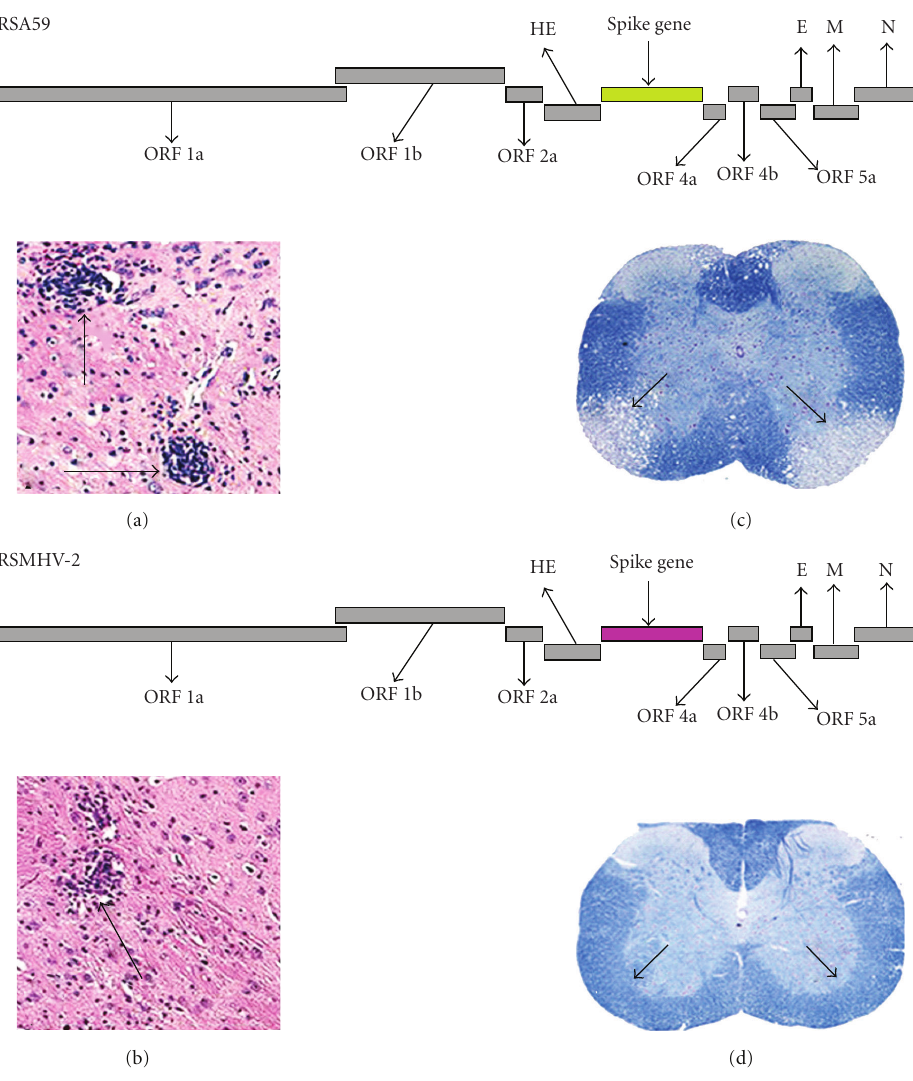
Figure 9: Comparative CNS pathology of mice infected with isogenic recombinant strains di ff ers in the S gene. Schematic diagram of isogenic recombinant strains RSA59 (S gene denoted in green color) and RSMHV2 (S gene demoted in pink color). Encephalitis (a, b). Haematoxylin- and eosin stained brain sections from the basal fore brain of mice infected with either RSA59 (a) or RSMHV2 (b) at day 5 post infection. Arrows indicate regions of inflammation. Demyelination (c, d): spinal cord sections of mice infected with RSA59 (c) or RSMHV2 (d) at day 30 post infection were stained with Luxol fast blue. The arrows indicate a region of demyelination in (c) and normal myelinated areas of white matter in